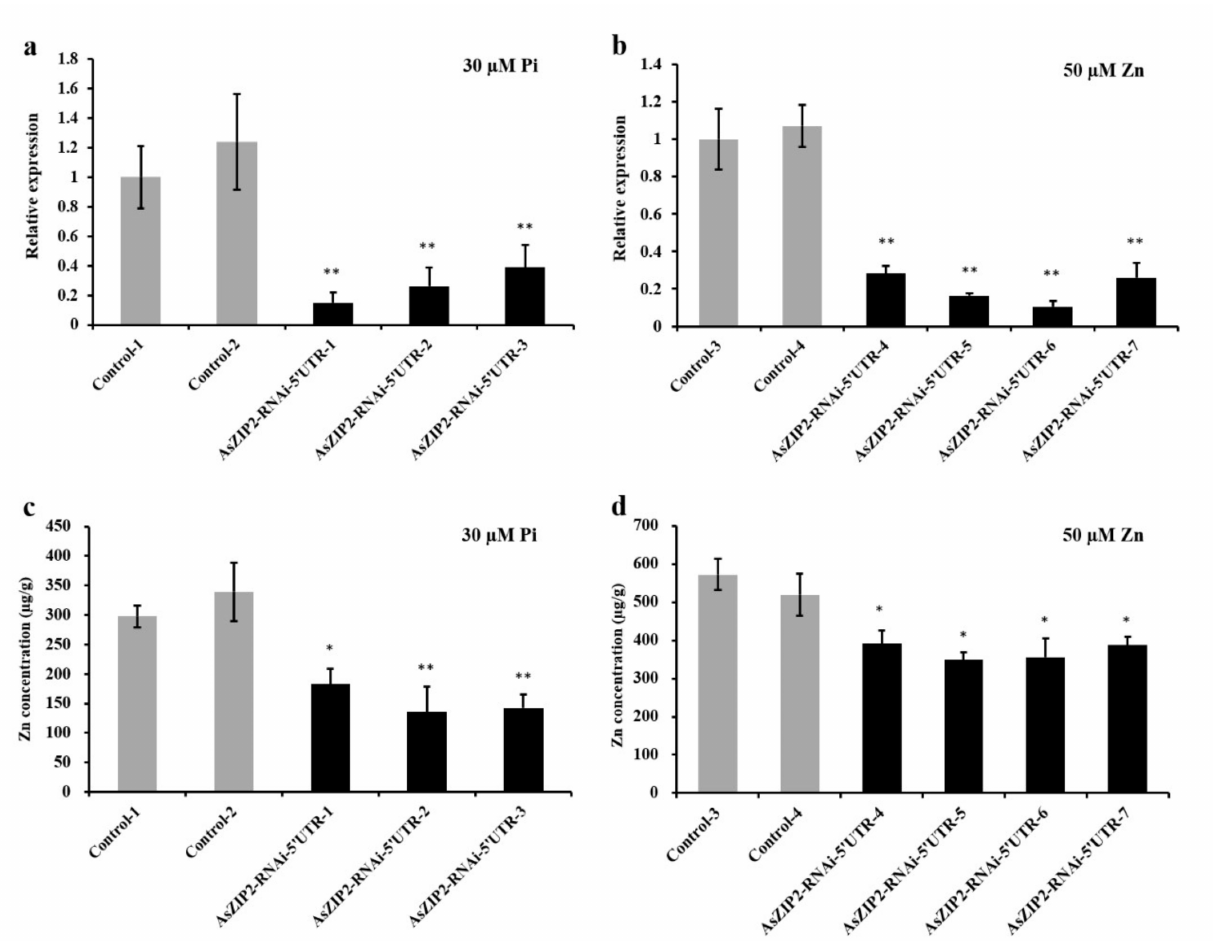
Figure 9. Zn concentration in transgenic A. sinicus lines silencing AsZIP2 ( AsZIP2-RNAi lines) and in control lines grown under Pi starvation or moderately high Zn supply. ( a , b ) Real time qRT-PCR analysis of AsZIP2 transcript levels in the control and RNAi lines of A. sinicus grown under Pi starvation (30 µ M) or moderately high Zn (50 µ M ZnCl 2 ) conditions. AsZIP2-RNAi-5 (cid:48) UTR-1 to AsZIP2-RNAi-5 (cid:48) UTR-7 represented independent transgenic lines. AsActin served as the control. ( c ) The Zn concentrations in the control and AsZIP2-RNAi roots of 56-d-old A. sinicus plants grown in cultures exposed to Pi starvation (30 µ M). ( d ) The Zn concentrations in the control and AsZIP2-RNAi roots of 56-d-old A. sinicus plants grown under the moderately high Zn concentration (50 µ M ZnCl 2 ). Error bars represent the SD for means of three technical replicates. Significant differences between the AsZIP2-RNAi lines and controls: **, p < 0.01; *, p < 0.05; Student’s t